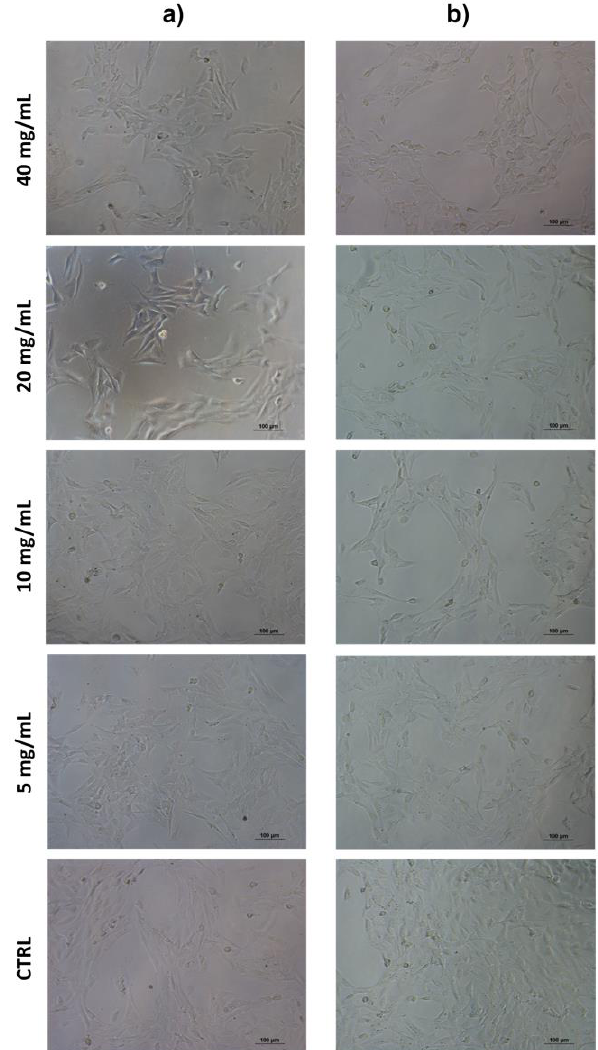
Figure 14. Optical micrographs of Balb/3T3 clone A31 cultured with several concentrations of PEGMA- ran -FA for 24 h (10× magnification). Photos taken after cell incubation at 37 °C ( a ) and after washing at room temperature ( b ).